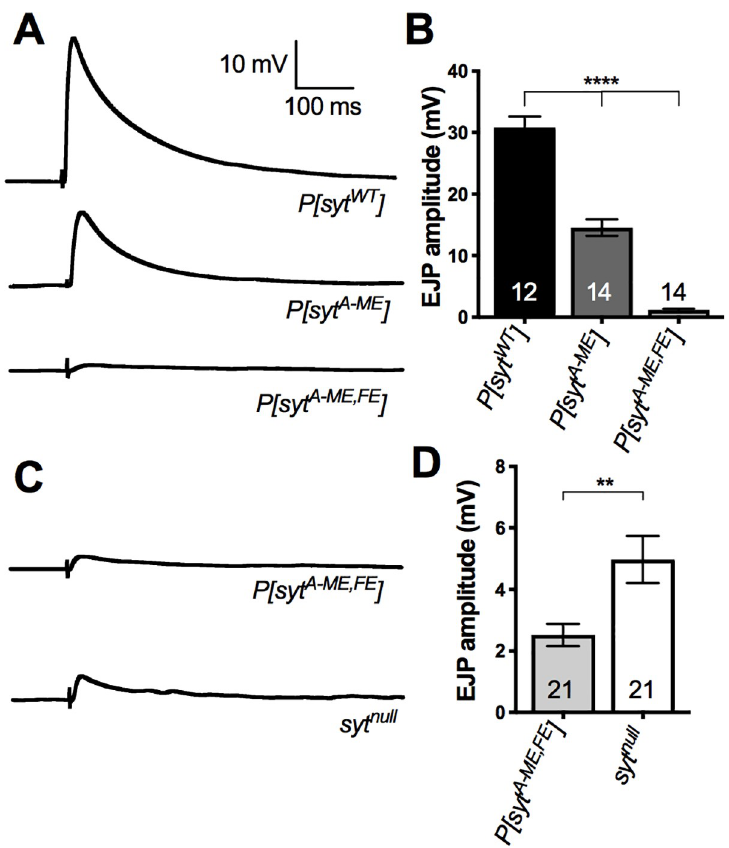
Fig 2. Mutation of the hydrophobic tip residues disrupts evoked transmitter release. The single hydrophobic mutation decreased neurotransmitter release by 50% while the double mutation inhibited release to a greater extent than that seen in syt null mutants. A, Representative traces of EJPs for P[syt WT ] , P[syt A-ME ] , and P[syt A-ME , FE ] . B, Mean EJP amplitude ± SEM for P[syt WT ] , P[syt A-ME ] , and P[syt A-ME , FE ] (Tukey multiple comparisons, p < 0.0001 = ���� ). C, Representative traces of EJPs for P[syt A-ME , FE ] and syt null . D, Mean EJP amplitude ± SEM for P[syt A-ME , FE ] and syt null (Tukey multiple comparisons, p < 0.01 = ��